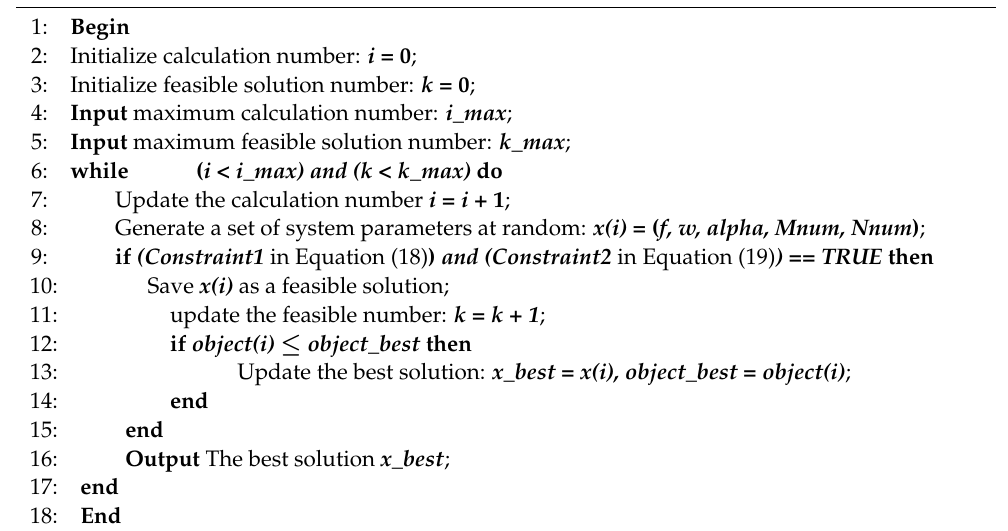
Algorithm 1: System parameter design algorithm